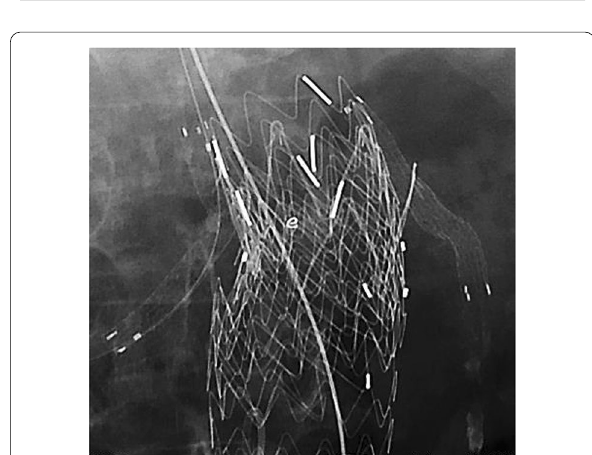
Fig. 4 Double snorkel technique was performed with an additional stentgraft cuff deployed parallel to the Viabahn